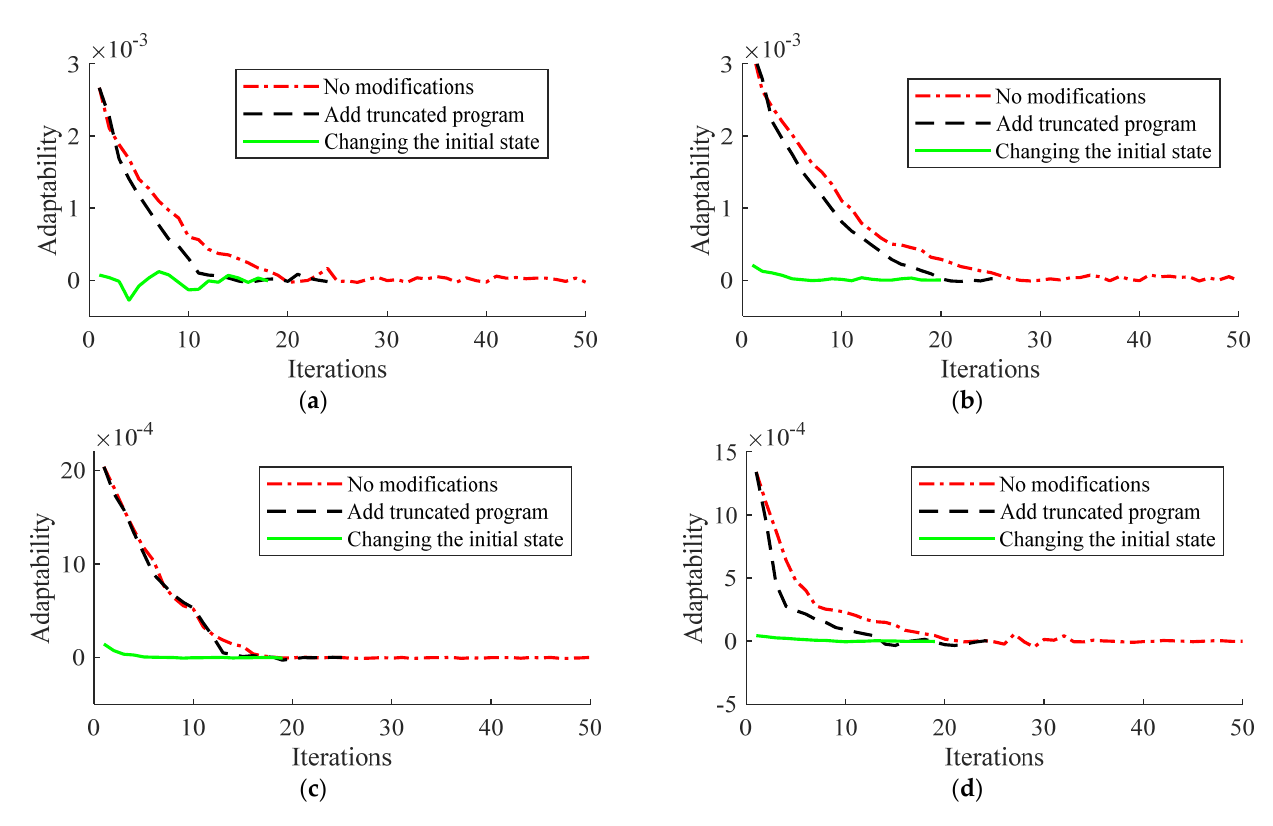
Figure 5. Adaptation curve comparison chart. ( a ) The adaptability of the three methods is at the first point; ( b ) the adaptability of the three methods is at the second point; ( c ) the adaptability of the third method is at the first point; ( d ) the adaptability of the three methods is at the fourth point.